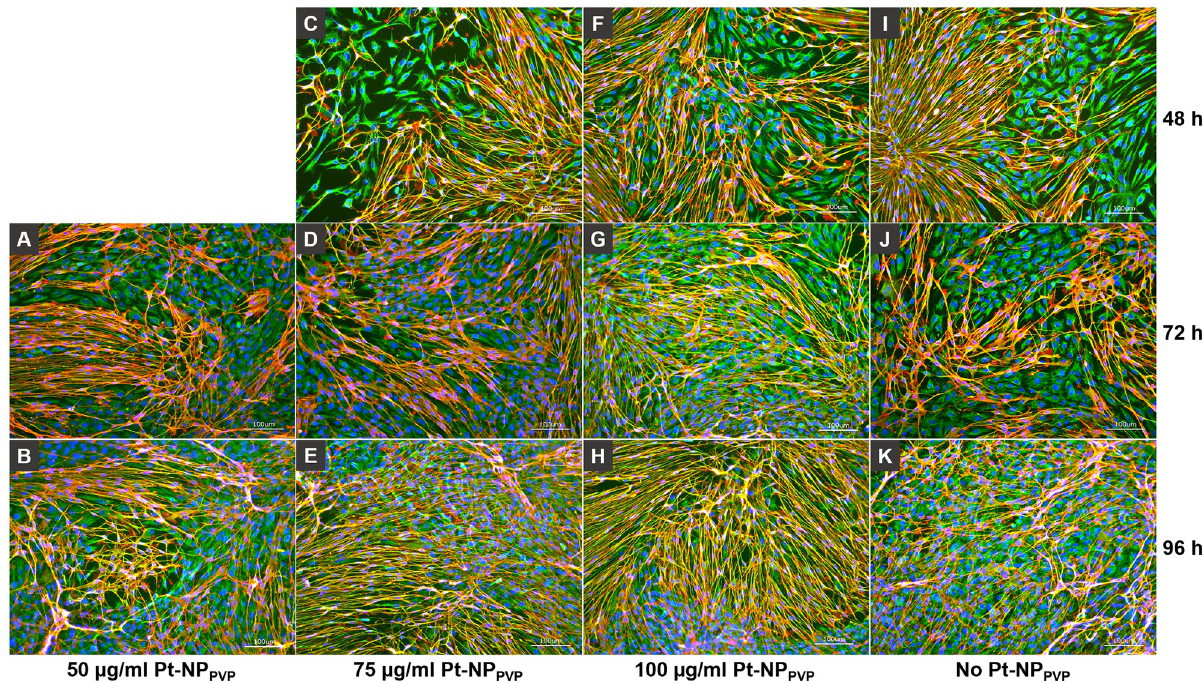
Fig 8. Representative fluorescence images of immunostained SG cells following Pt-NP PVP application for 48 h, 72 h and 96 h. Representative fluorescent microscopic views of fibroblasts and glial cells, labelled with anti-vimentin (Vim, green) and anti-p75 neurotrophic growth factor receptor (p75-NGFR, red) antibody, respectively. Nuclei were stained with DAPI. Positive staining against vimentin and p75-NGFR antigens were found in cell culture assays without Pt-NP PVP incubation (I-K) and supplied with 50 μ g/ml (A-B) for 72 h and 96 h cultivation, 75 μ g/ml (C-E) and 100 μ g/ml Pt- NP PVP (F-H) for 48 h, 72 h and 96 h cultivation, respectively. Staining of the fibroblasts and glial cells showed widespread cell adhesion and growth not only at the highest Pt-NP PVP concentration, but also independently of the cultivation period. Size of the bars 100 μ